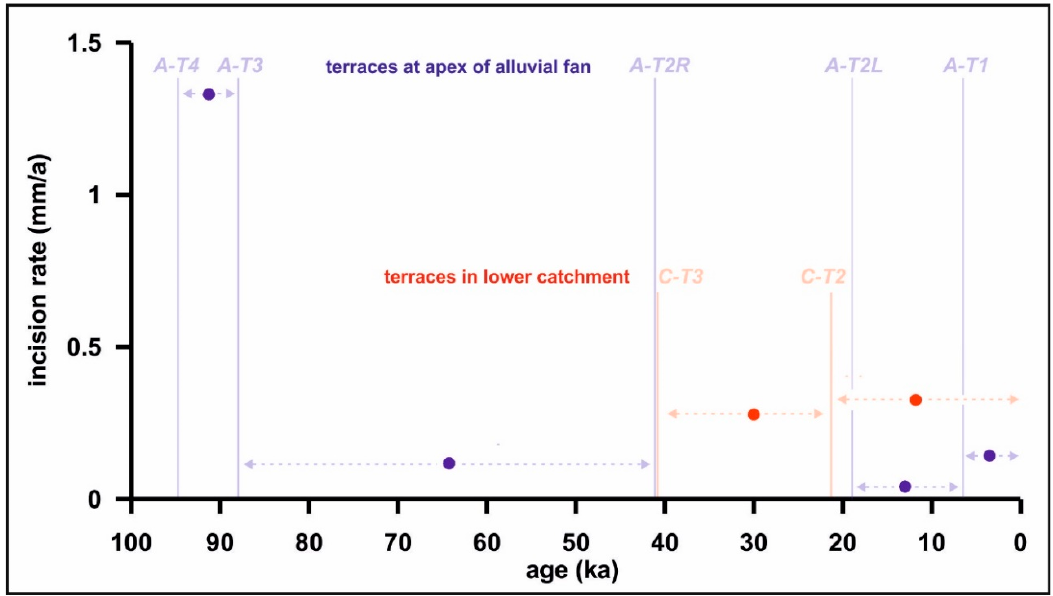
Figure 7. Approximate average local incision rates for the investigated sites at the main eastern river in the lower catchment (red circles) and at the apex of the present-day alluvial fan (blue circles). The rates were derived by relating bedrock incision between the dated fluvial terrace levels with the elapsed time. However, one should be aware that the averaged erosion rates possibly encompass shorter periods of higher and lower rates than the averages. The luminescence ages of the terrace levels (without errors) are shown with solid vertical